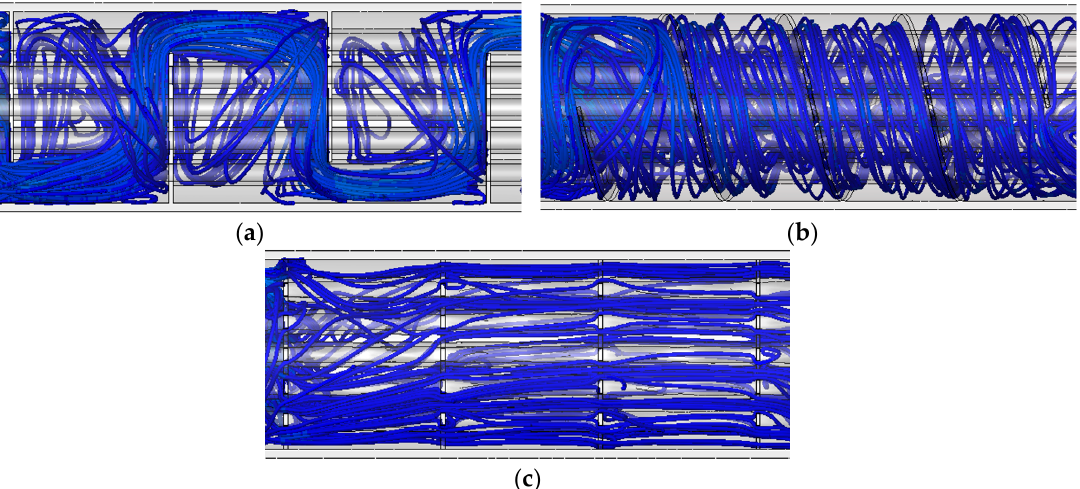
Figure 5. Shell path lines: ( a ) segmental baffles; ( b ) helical baffles; and ( c ) clamping antivibration baffles.